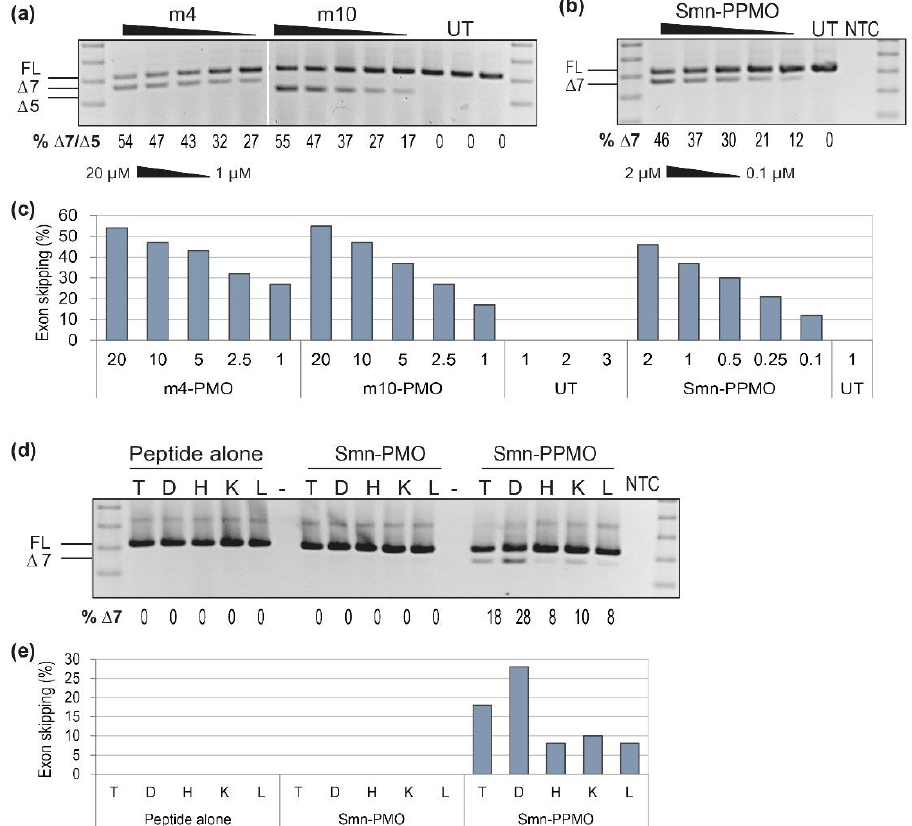
Figure 5. RT-PCR analysis of Smn products across exons 4 to 8 in; ( a ) mdx mouse myoblasts transfected with the exon 7 and 5 PMOs (20, 10, 5, 2.5, and 1 µM) and compared to untreated (UT) myoblasts; ( b ) mdx mouse myoblasts transfected the exon 7 Smn-PPMO (2, 1, 0.5, 0.25 and 0.1 µM) and compared to untreated (UT) myoblasts, with the graphed densitometry of ( a ) and ( b ) shown in ( c ) and ( d ) tissue harvested from mdx mice treated with either an un-conjugated peptide, unconjugated PMO (3x subcutaneous (2 nmol) injections) or the Smn-PPMO (1x subcutaneous (2 nmol) and 1x intraperitoneal (2 nmol) injections), with the graphed densitometry shown in ( e ). Tissues evaluated include the tibialis anterior (T), diaphragm (D), heart (H), kidney (K) and liver (L). The full length transcript (FL, 430 bp) and exon skipped products (delta-7( ∆ 7), 380 bp) are indicated by the lines to the left of the gel. The percentage of ∆ 7- Smn transcripts, as determined by densitometry, are shown below each lane. A 100 bp size marker was used for size comparison and a no template RT-PCR control (NTC) was loaded in the final